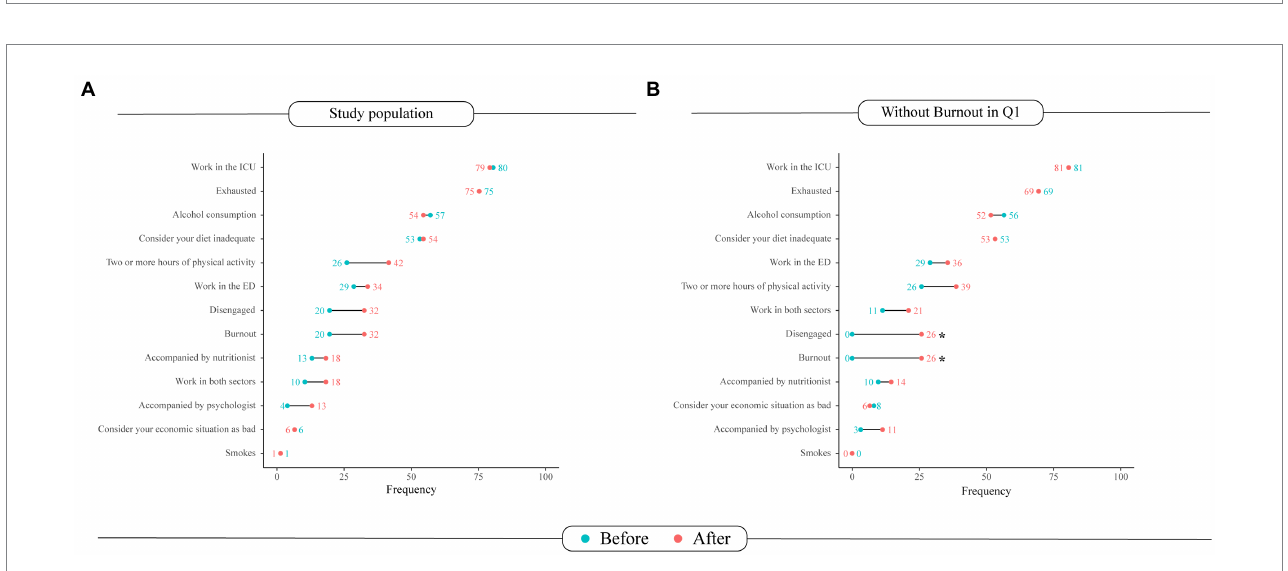
FIGURE 3 Changes in the Burnout questionnaire in the (A) overall study population and in the (B) participants who have not developed burnout. In blue, the frequencies of the characteristics in the first questionnaire are represented as % of the study participants. In red, frequencies obtained in the second questionnaire. Asterisks indicate statistically significant differences (value of p < 0.05). Intensive Care Unit (ICU), Emergency Department